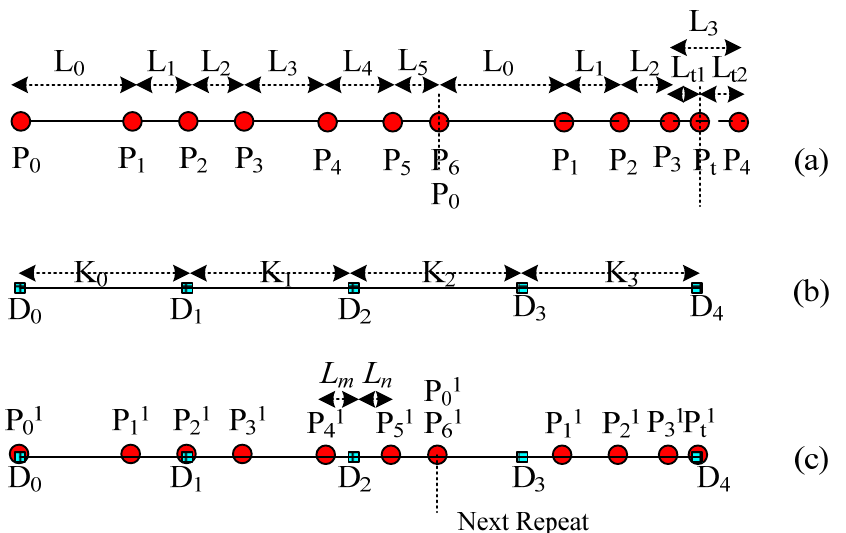
Figure 6. The calculation of key point spacing along the central curve and the combination of the sorting of key points. ( a ) Calculate the distance to the mapping start P 0 for each key control point on the source yarn. ( b ) Calculate the distance to the mapping start D 0 for each key point on the target curve. ( c ) Combine and rearrange all the key points of both source yarn and target curve in order on the new central curve according to the distances to the random mapping start P 0 or D 0 .